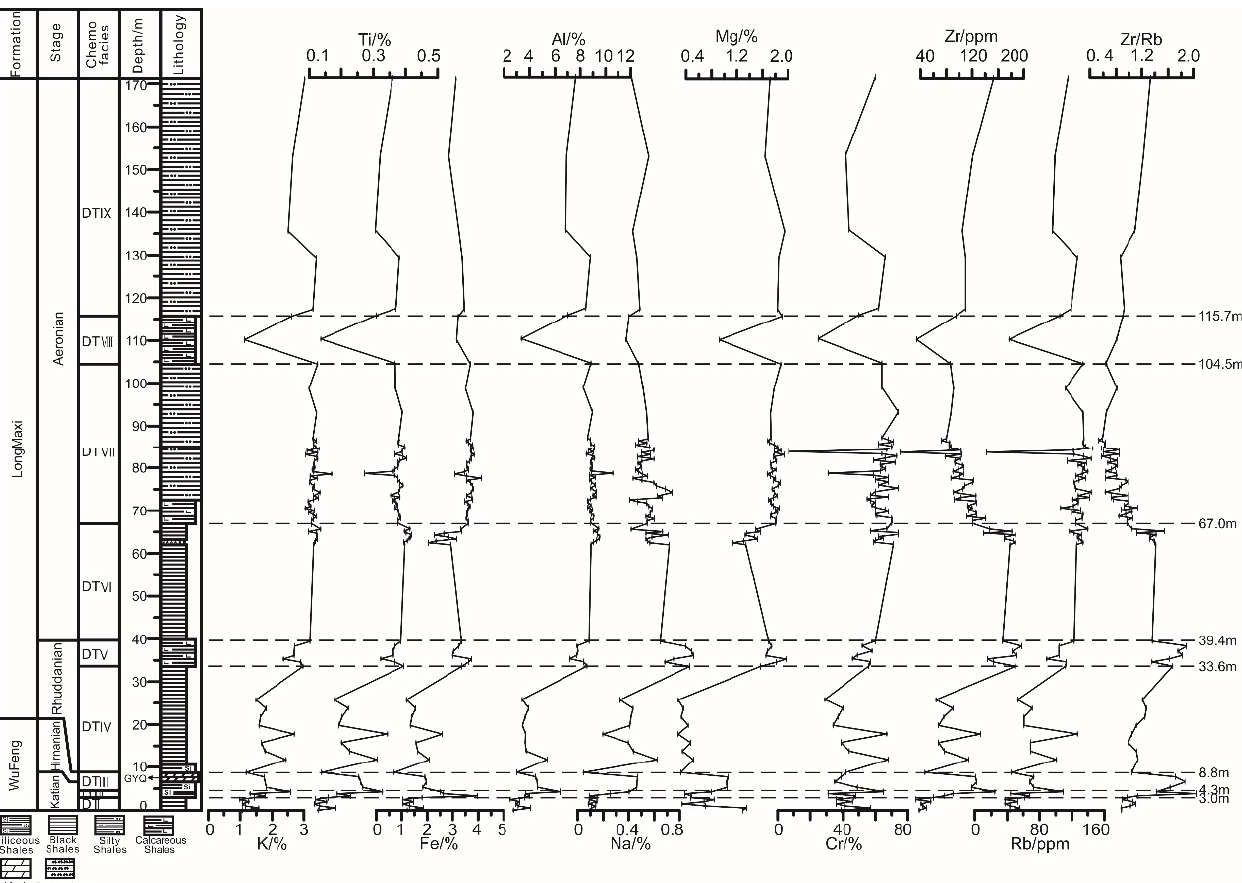
Figure 3. The chemozones based on detrital chemofacies of the Changning section.